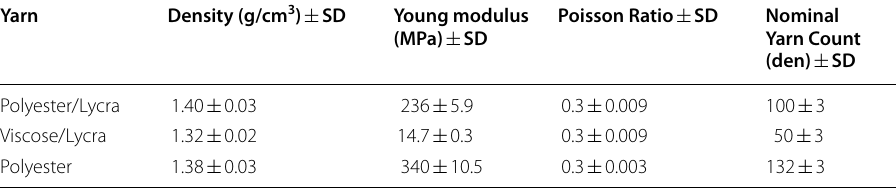
Table 1 Physical and mechanical properties of yarn samples Yarn